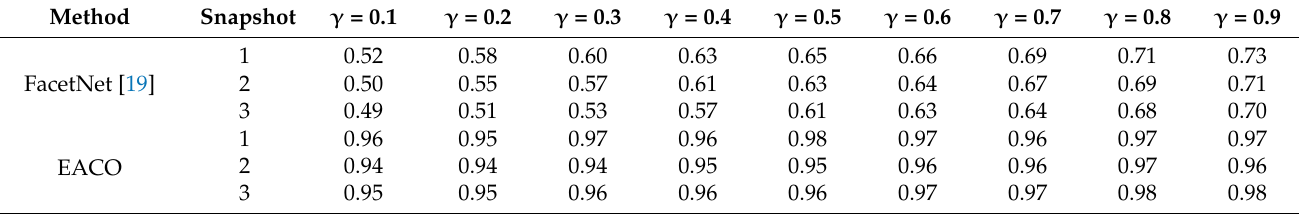
Table 3. NMI values of the experimental results obtained by FacetNet and